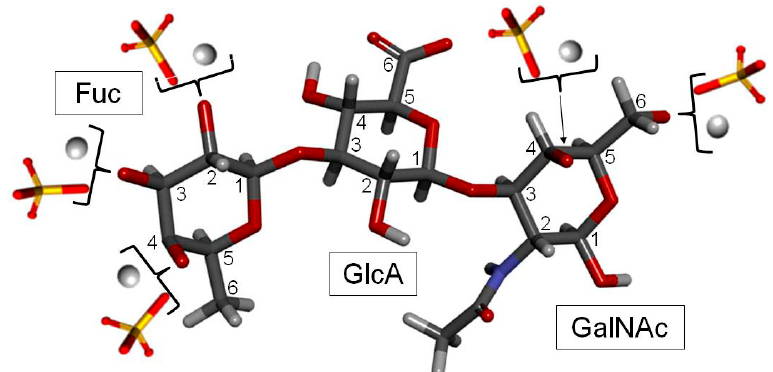
Figure 6. Representative trisaccharide unit { → 4)-[ α -L-Fucp-(1 → 3)]- β - D -GlcA-(1 → 3)- β - D -GalNAc-(1 → } of the FucCS backbone from sea cucumber in its 3D stick models. The sites of possible substitution by sulfate groups are C2, C3 and C4 of Fuc p unit and C4 and C6 of GalNAc as indicated in the structure. Hydrogens, carbons, oxygens and nitrogens are represented in light grey, dark grey, red and blue, respectively. Carbon atoms are numbered according to their positions in the ring. Monosaccharides are indicated accordingly. Model created by the online AMBER / GLYCAM-based carbohydrate builder